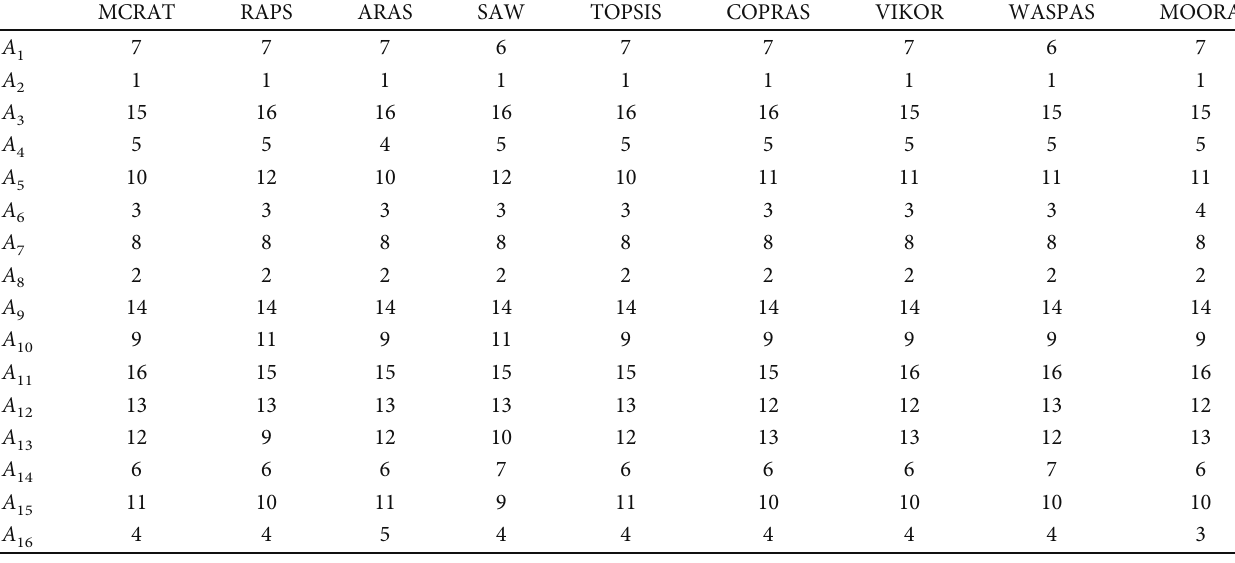
Table 11: Ranking materials of break booster valve body by di ff erent MCDM methods.